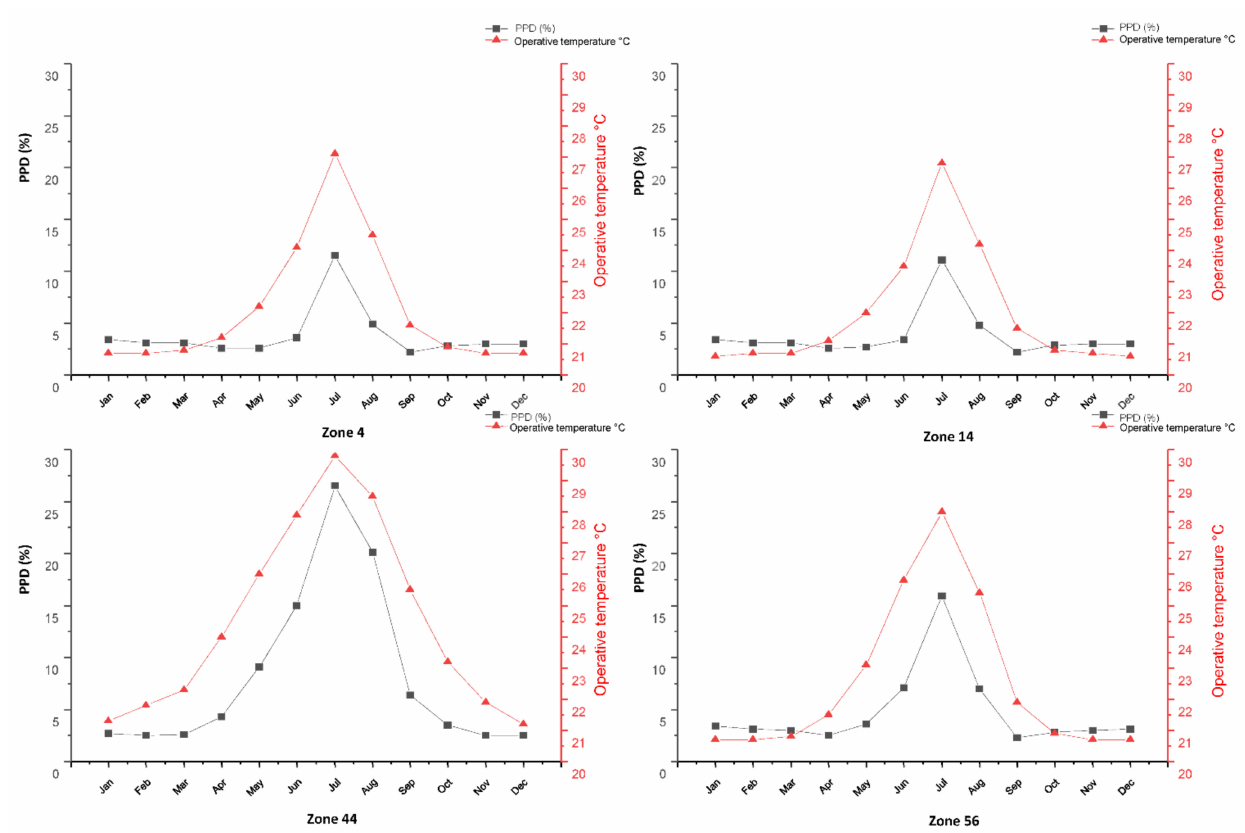
Figure 15. Monthly predicted percentage of dissatisfied (PPD (%)) and operative temperatures for zone 4, zone 14, zone 44 and zone 56 in case A (no low-E film).